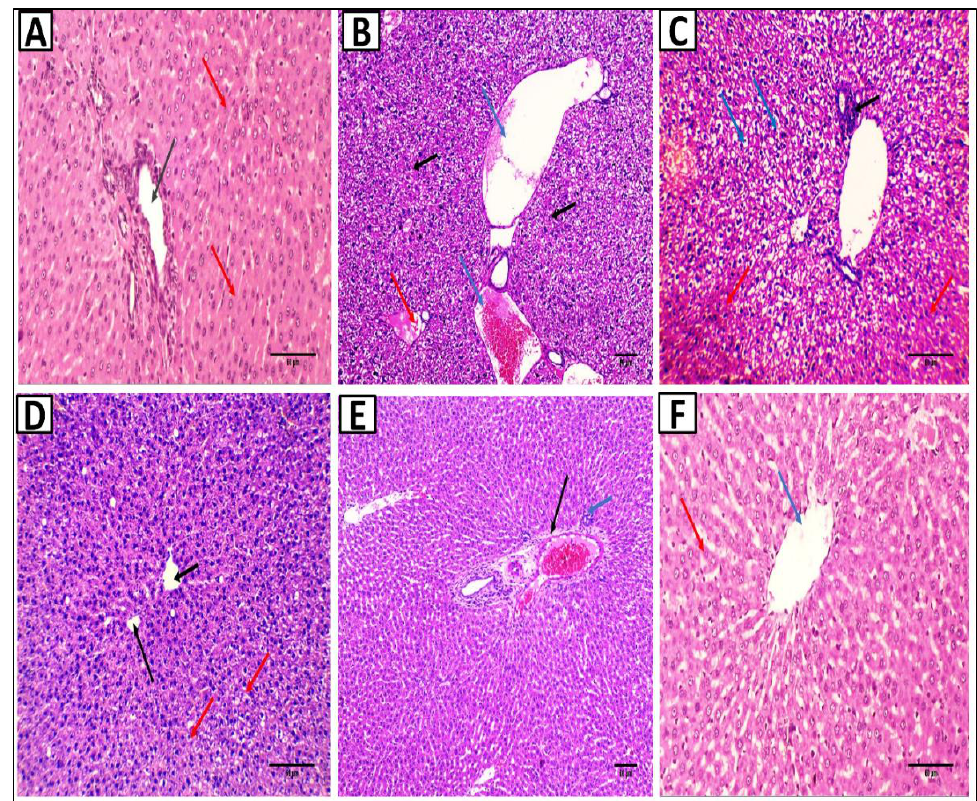
Figure 10. Histopathological examination of the liver sections stained with hematoxylin and eosin (H&E). ( A ) A section in the liver of the control group showed portal tract (portal venule, hepatic arteriole, and bile ductule) (black arrow) surrounded by cords of hepatocytes (red arrows) [H&E × 200]. ( B ): Section in the liver of MTX group showed congested central vein (red arrow), dilated por- tal venule, and hepatic arteriole (blue arrows) surrounded by cords of hepatocytes showing focal necrosis (black arrows) [H&E × 100]. ( C ): Section in the liver of MTX group showed portal tract showing chronic inflammatory cellular infiltrate (black arrow) surrounded by cords of hepatocytes showing hydropic degeneration (blue arrows) and focal necrosis (red arrows) [H&E × 200]. ( D ): Section in the liver of SAME 10 group showed average-sized central veins (black arrows) sur- rounded by cords of average-sized hepatocytes, some of which showed hydropic degeneration (red arrows) [H&E × 200]. ( E ): Section in the liver of the SAME 20 group showed mild dilated portal venule (black arrow) surrounded by a few chronic inflammatory (blue arrow) surrounded by cords of average-sized hepatocytes with no necrosis or degeneration [H&E × 100]. ( F ): Section in the liver of the SAME 30 group showed an average-sized central vein (blue arrow) surrounded by cords of hepatocytes (red arrow) with no necrosis, degeneration, or inflammation [H&E × 200].